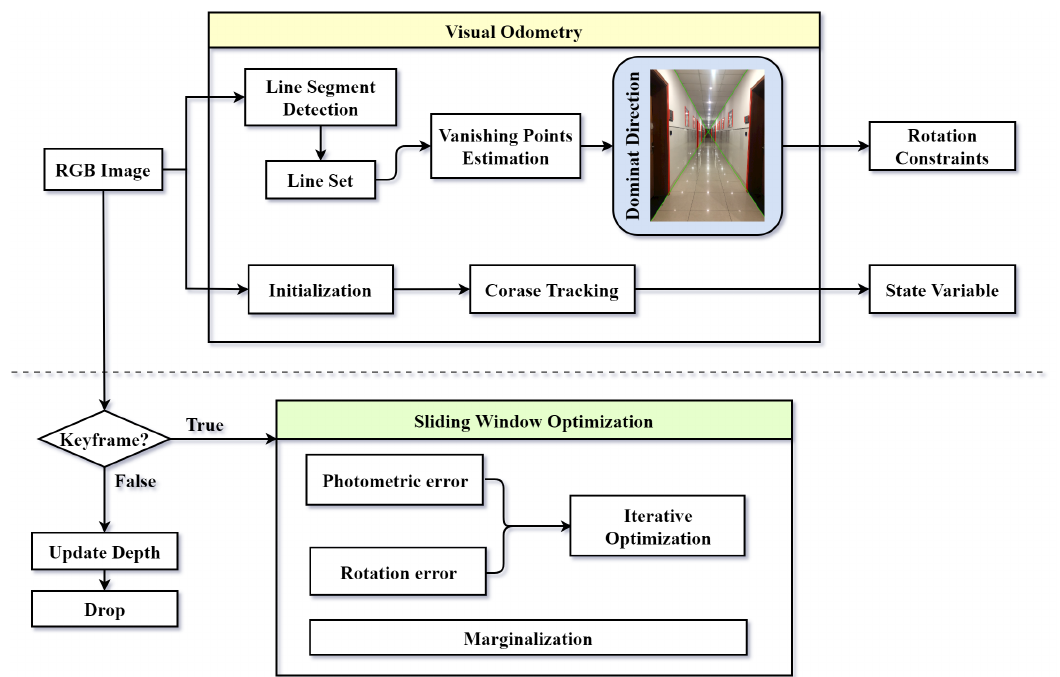
Figure 2. Overview of the proposed VO pipeline.